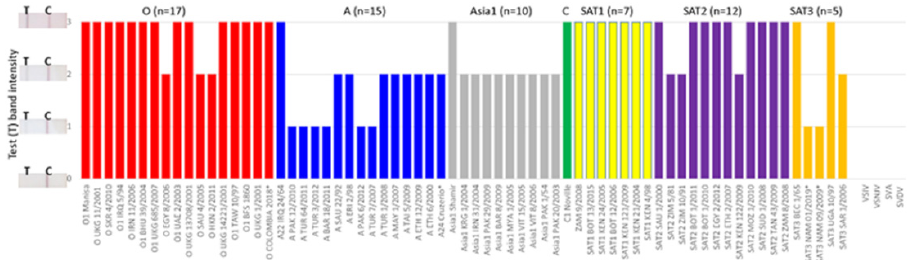
Figure 2. Pan-serotype FMDV strip test results for FMDV and other vesicular disease viruses in cell culture supernatants. Samples were each mixed with biotinylated recombinant bovine integrin α v β 6 and a gold-conjugated monoclonal antibody (mAb F21-42) in running buffer. A gRAD strip per sample was dipped into the tube containing this mixture which ran through the strip by capillary action, and the results were determined after 10–30 min. A positive result is indicated by visible bands on both the test line (T) and the control line (C). A negative result is indicated by a visible band on the control line only. A score of 0, 1, 2 or 3 was recorded for a negative, weak, medium or strong positive test (T) result (band intensity), respectively. An image of a strip test band intensity is shown besides the corresponding numerical score on the Y axis. Table 1. Comparison of analytical sensitivities of antigen detection ELISA (AgELISA) and